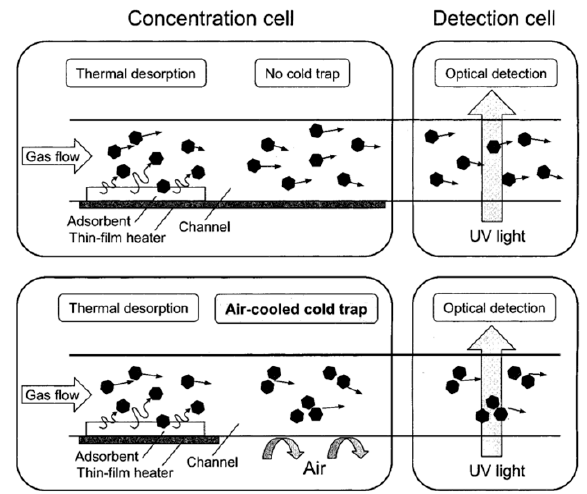
Figure 10. Schematic illustrating the effect of the integration of the CT in the concentration cell. Reproduced with permission. [26] Copyright 2002, American Chemical Society.